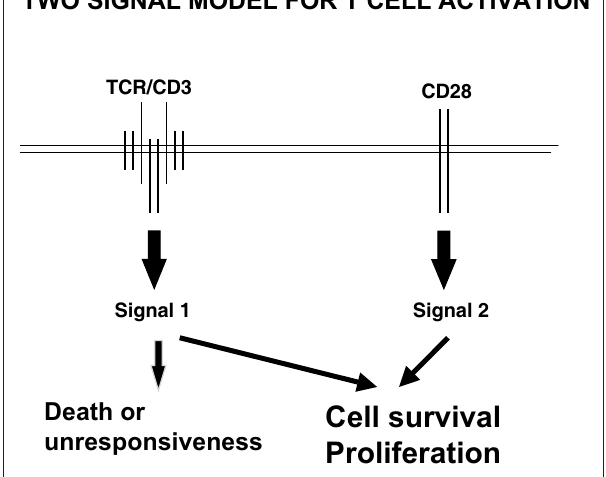
Figure 3) The two signal model for T cell activation. Binding of the T cell receptor (TCR)/CD3 complex to the antigen/major histocompati- bility complex (MHC) alone (signal 1) can lead to death or induction of a nonresponsive state in the T cell. Only when the T cell receives both a signal through its TCR as well as a costimulatory signal (signal 2) does it survive and make the cytokines necessary for T cell proliferation. Adapted from a figure kindly provided by Linda Wu Figure 4) Key players in the intiation of T cell activation. Antigen pre-